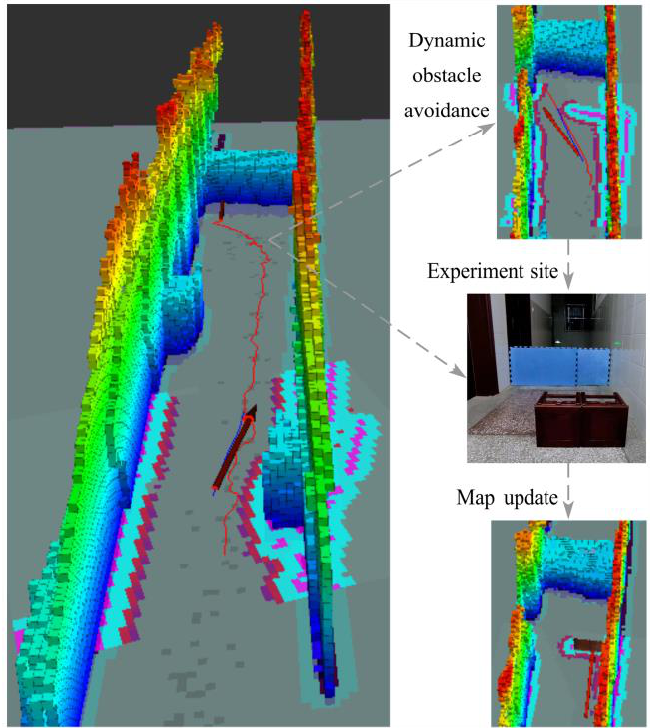
Figure 16. Navigation and obstacle avoidance based on the octree map and cost map.